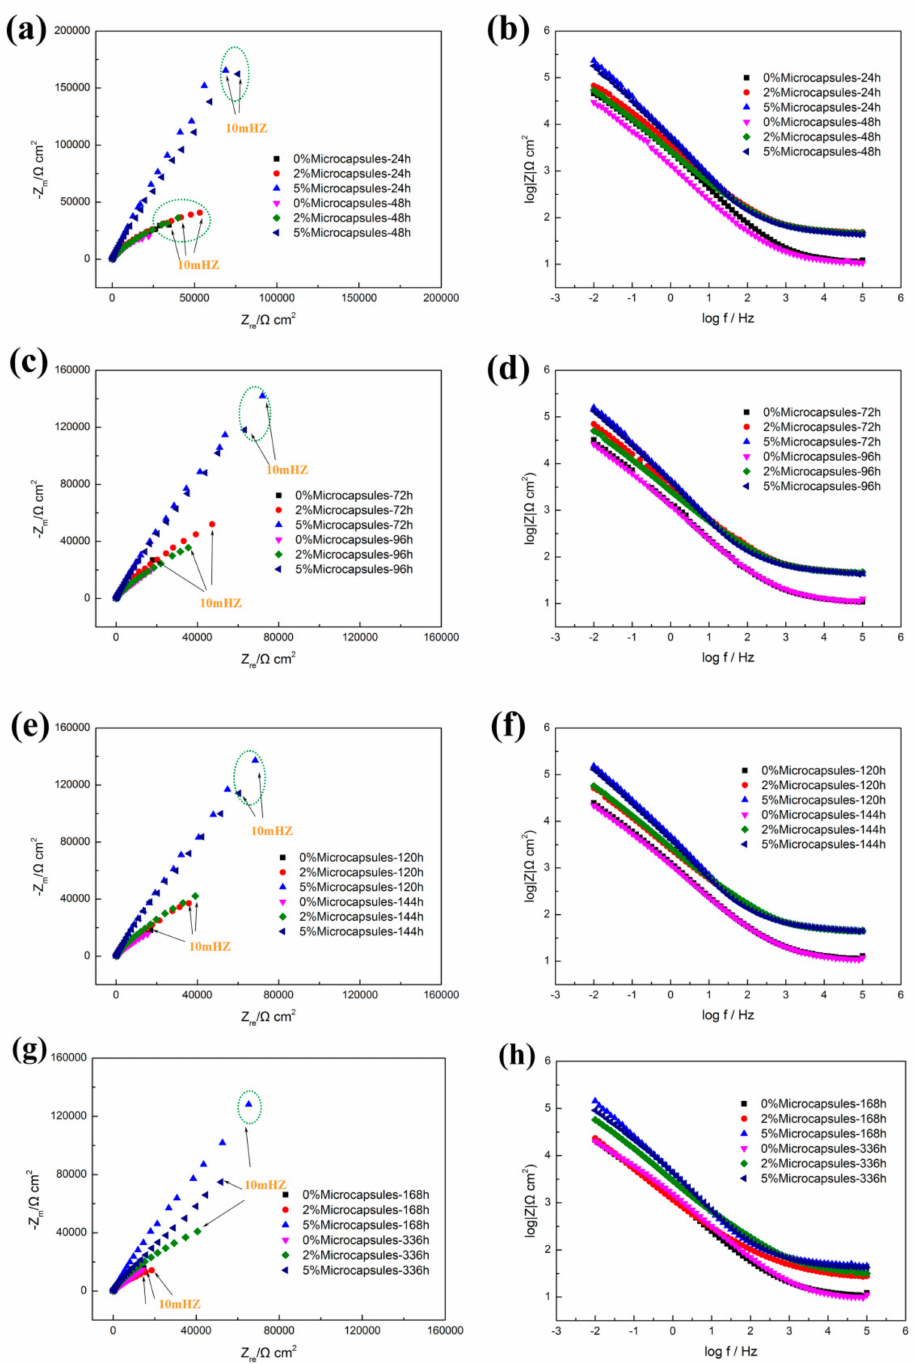
Figure 8. Nyquist and Bode plots of coatings with di ff erent contents of microcapsules (0.0 wt%, 2.0 wt% and 5.0 wt%) after being scratched and immersed in seawater for di ff erent times. ( a ) Nyquist plots after 24 and 48 h ( b ) Bode plots after 24 and 48 h ( c ) Nyquist plots after 72 and 96 h ( d ) Bode plots after 72 and 96 h ( e ) Nyquist plots after 120 and 140 h ( f ) Bode plots after 120 and 140 h ( g ) Nyquist plots after 166 and 336 h ( h ) Bode plots after 166 and 336